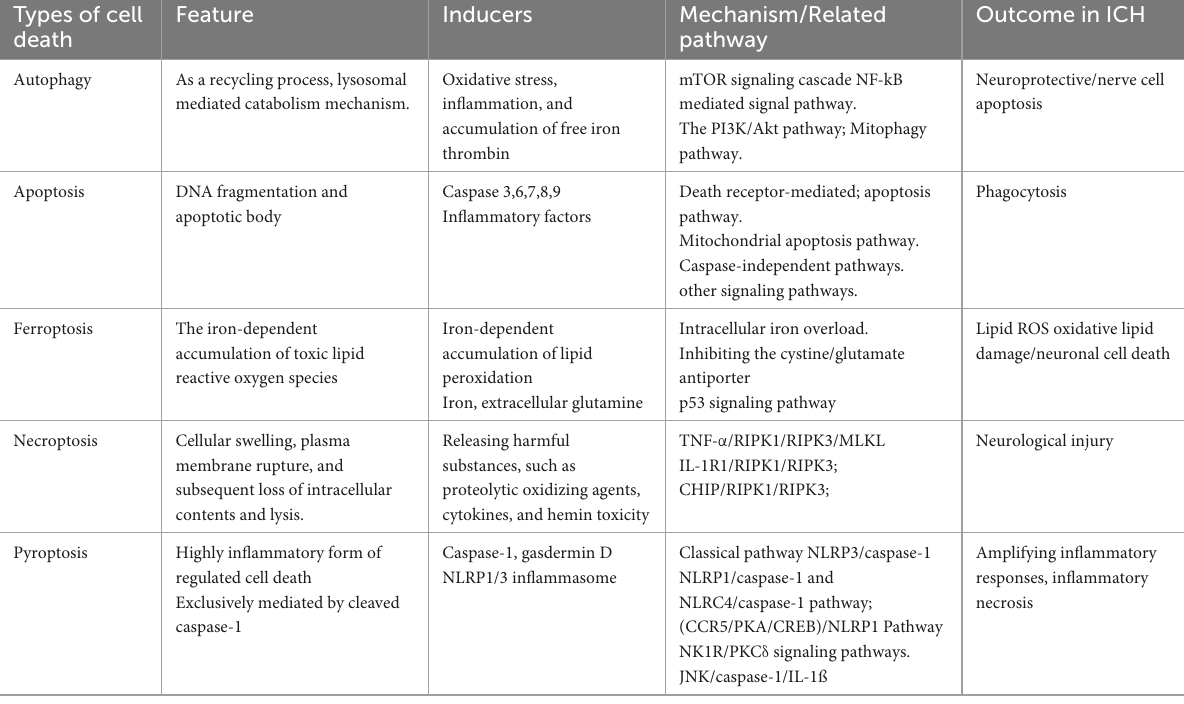
TABLE 2 Comparison of different ICH-induced cell